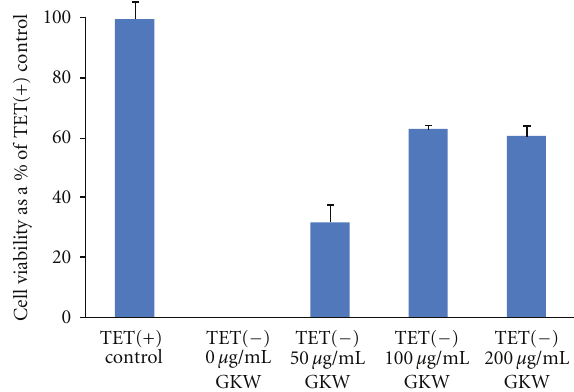
Figure 5: E ff ect of GKW on survival of MC65 cells following tetracycline withdrawal. Cell viability is expressed as a % of the cell growth obtained in control cultures containing tetracycline, TET(+). On withdrawal of tetracycline from the media, TET( − ), the cells generate endogenous A β and die within 3 days. In the absence of GKW, cell survival in TET( − ) cultures is zero. GKW dose-dependently protects MC65 cells from cell death in TET( − ) cultures ( P < 0 . 01 at 50, 100, and 200 μ g/mL compared to 0 μ g/mL GKW; Student’s t -test). Mean values of cell viability ± SD are shown.